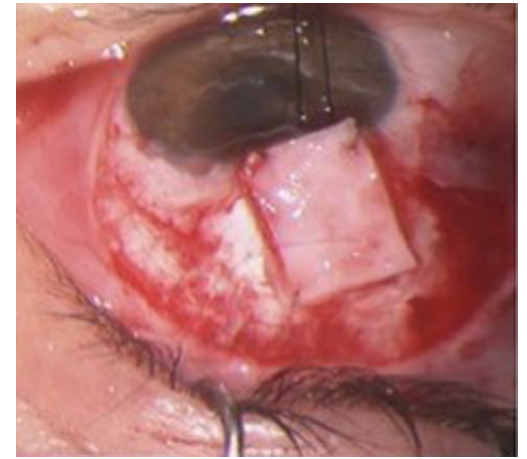
Figure 5: Tutopatch graft ®